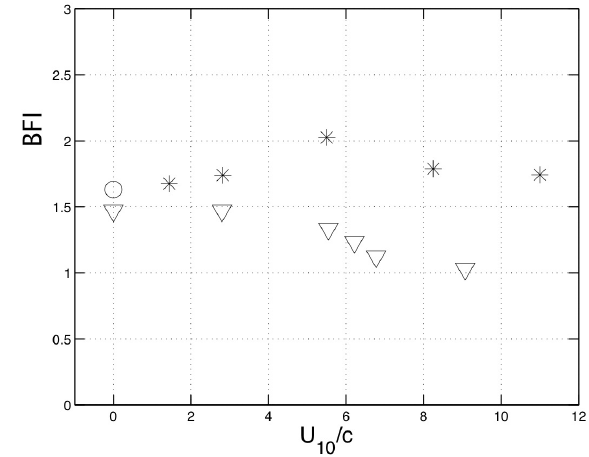
Figure 4. Modulational index BFI versus wind-forcing parameter U / c . Record with f 0 = 1.6 Hz and ε 0 = 0.23 is designated by circle. Waves with f 0 = 1.6 Hz and ε 0 = 0.24 are indicated by triangles. Crosses are data taken from [14] ( f 0 = 1.0 Hz and ε 0 =